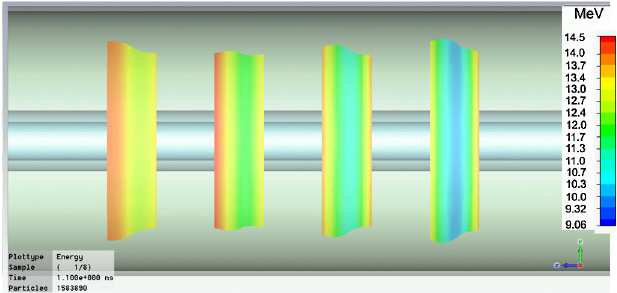
bunch.FIG. 10. Right side view of four drive bunches, initially cen- tered on the structure axis, moving from right to left, along a CDWA structure specified in Table I. The color scale on the right shows the energy of the particles. These drive bunches are spaced apart by one period of the design mode, 10.67 mm and have moved 1.1 nsec.